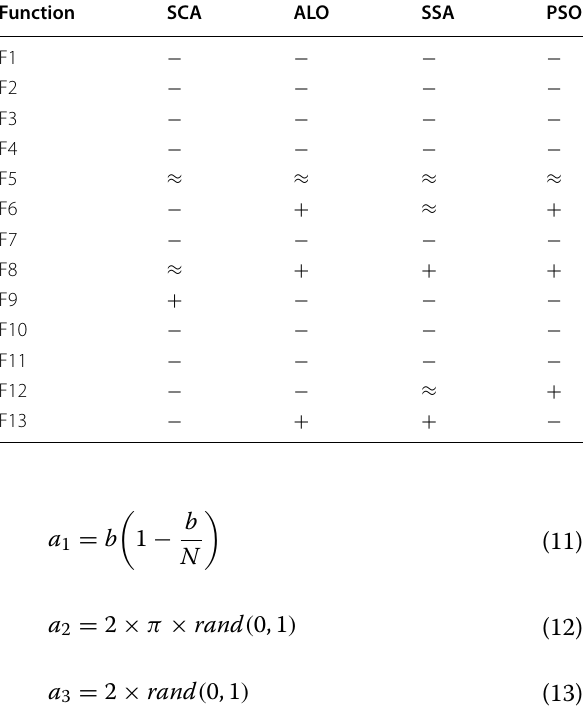
Bold value shows the best value